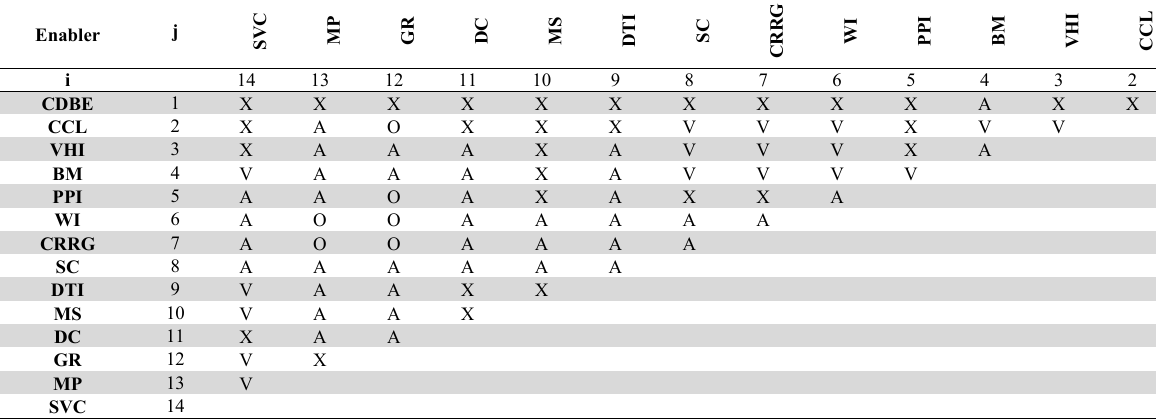
Final Structural Self-Interaction Matrix after Delphi Round – 3 Enabler